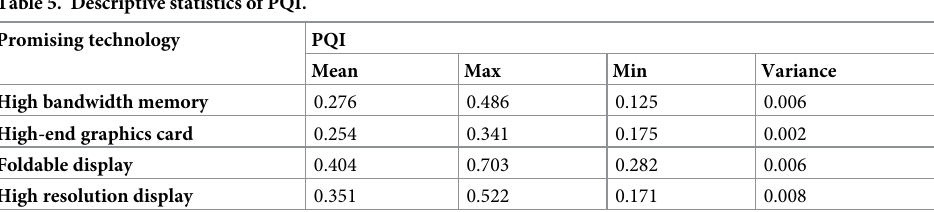
Table 5. Descriptive statistics of PQI.